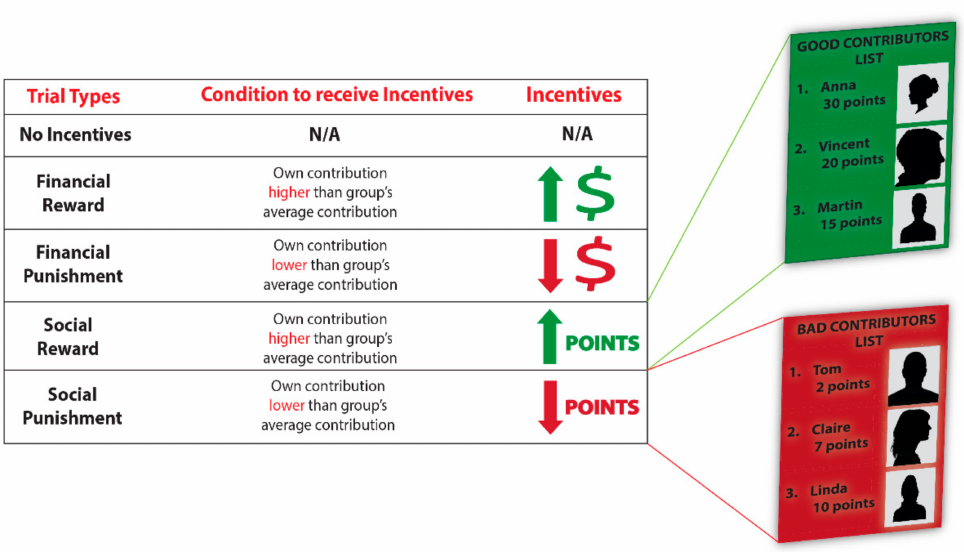
Figure 1. Overview of trial types. In the financial and social conditions, participants could receive incentives (rewards or punishments) based on their contributions to the group account. In the financial condition, these incentives were monetary, while in the social condition, these incentives were social, consisting of rankings on the Good or Bad Contributors List (based on participants’ performance in social reward and punishment trial types respectively). Participants’ rankings on the Good and Bad Contributors lists were calculated after all data were collected and were only shown to participants in this specific experiment after study